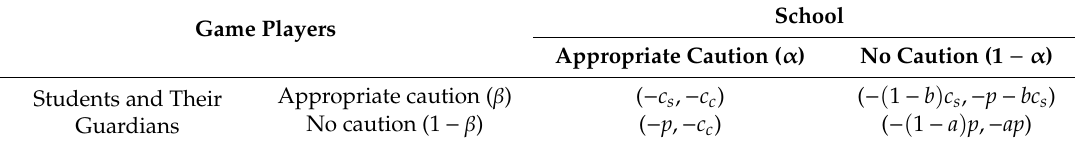
Table 1. The game matrix between the two